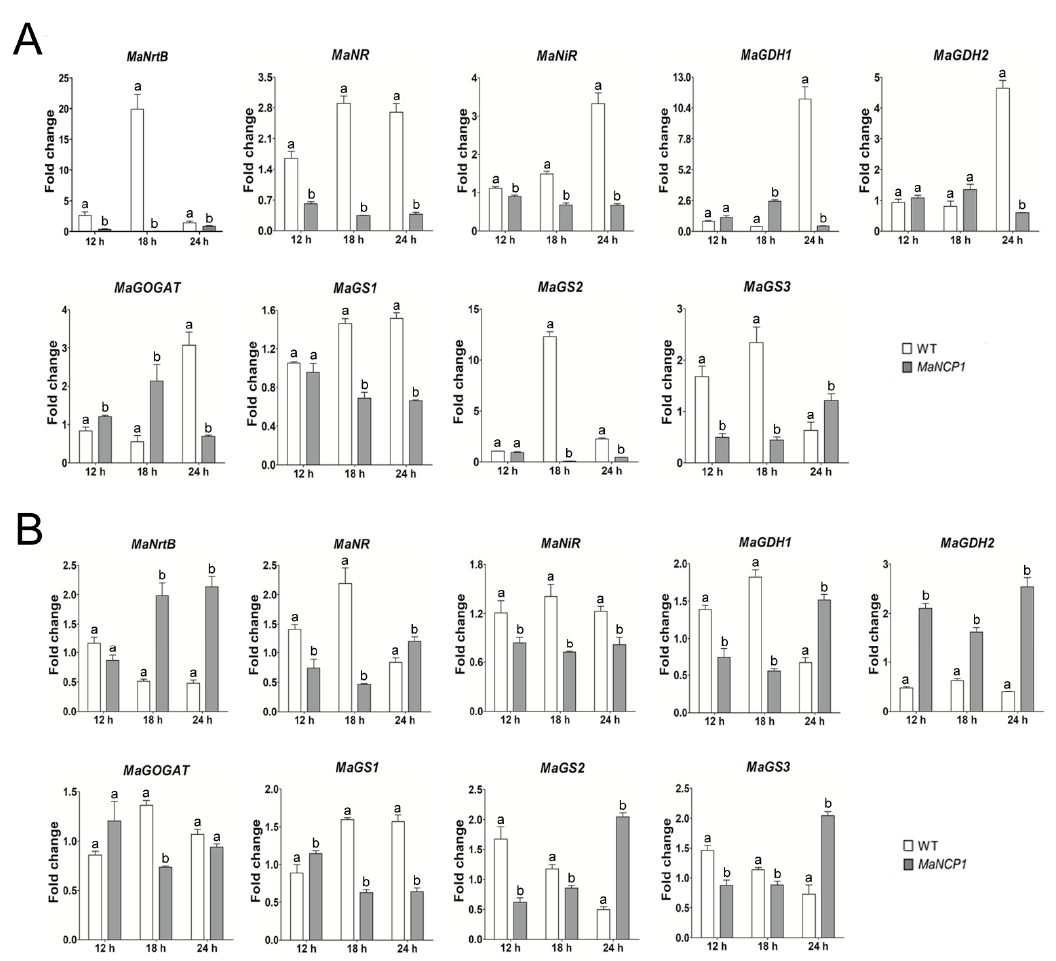
Figure 3. MaNCP1 regulated the expression of nitrate and ammonium assimilation genes. Transcription level analysis of genes in nitrate and ammonium assimilation pathway under SYA ( A ) and SYA + N ( B ) conditions. Fungal strains were cultured on SYA and/or SYA+N media for 12, 18 or 24 h. Lowercase letters indicate significant difference at p < 0.05 (T-text).